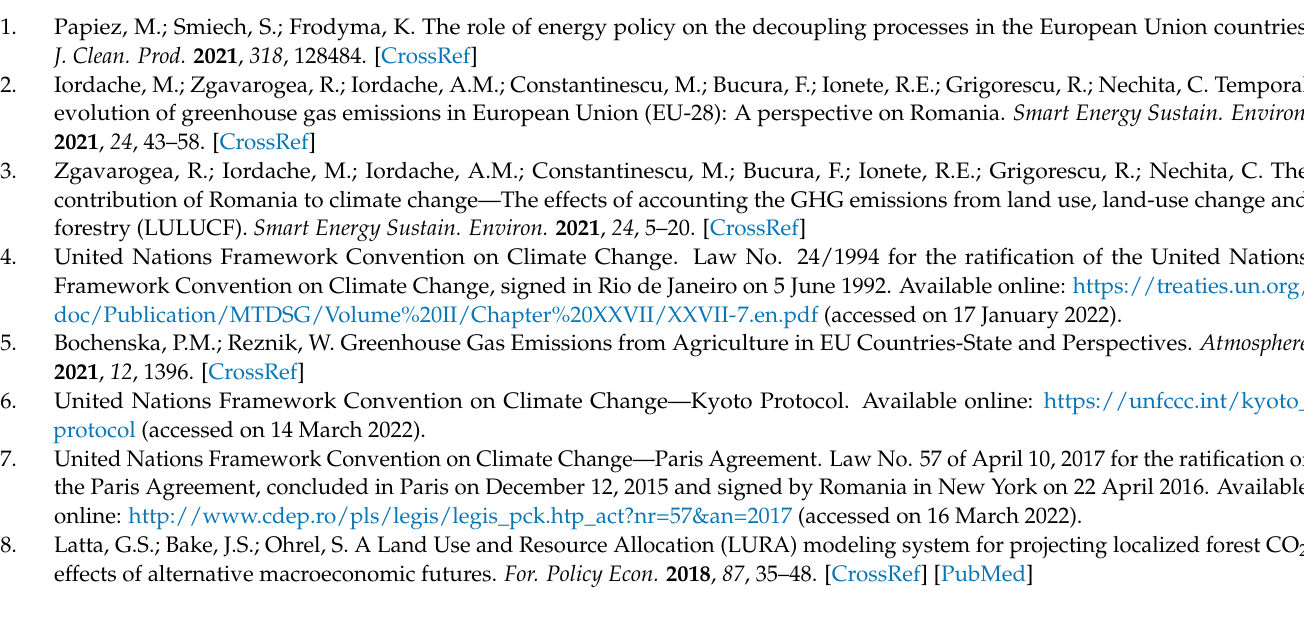
EU-27 + UK; Figure S3: GHG emissions vs . GHG removals average annual rate, by GHG type, EU-27 + UK; Figure S4: GHG emissions vs. GHG removals average annual rate, by GHG type, EU-27 + UK; Table S1: The LULUCF sector GHG emissions evolution, EU-27 + UK (kt CO 2 eq.); Table S2: Romanian’s LULUCF sector GHG emissions vs. GHG removals evolution, by scenario (kt CO 2